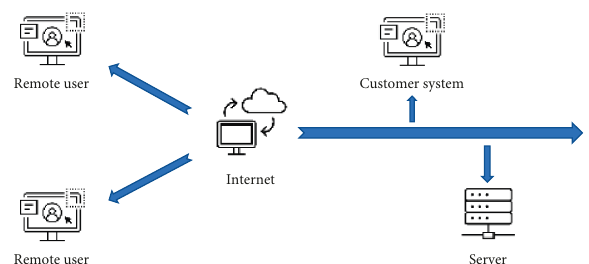
Figure 7: Structure of the digital art design effectiveness